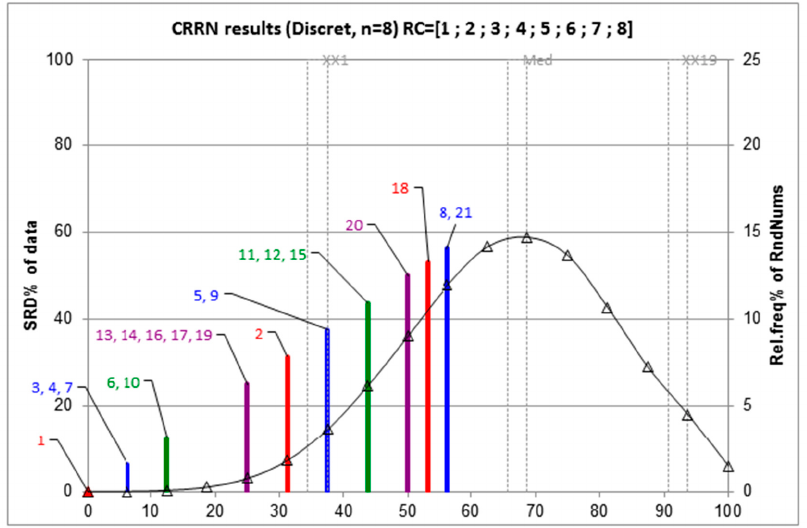
Figure 5. Descriptors choice evaluation using SRD with ties and a scaling between 0-100. The different colored lines represent ranking of different regression models, showcasing their relative position and extent of the similarity. The respective model numbers are provided as per Table 2. (reprinted from Ref. [79]. © 2019, IGI Global).